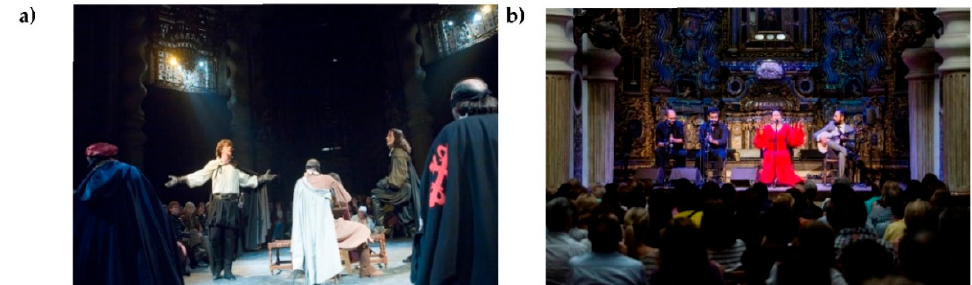
Figure 4. ( a ) Representation of the play Don Juan Tenorio. Classical Theatre Company of Seville (2005). http://www.clasicodesevilla.com/Don-Juan-Tenorio. ( b ) María Terremoto. Bienal de Flamenco, Seville (2016). http://www.labienal.com/galeria/.